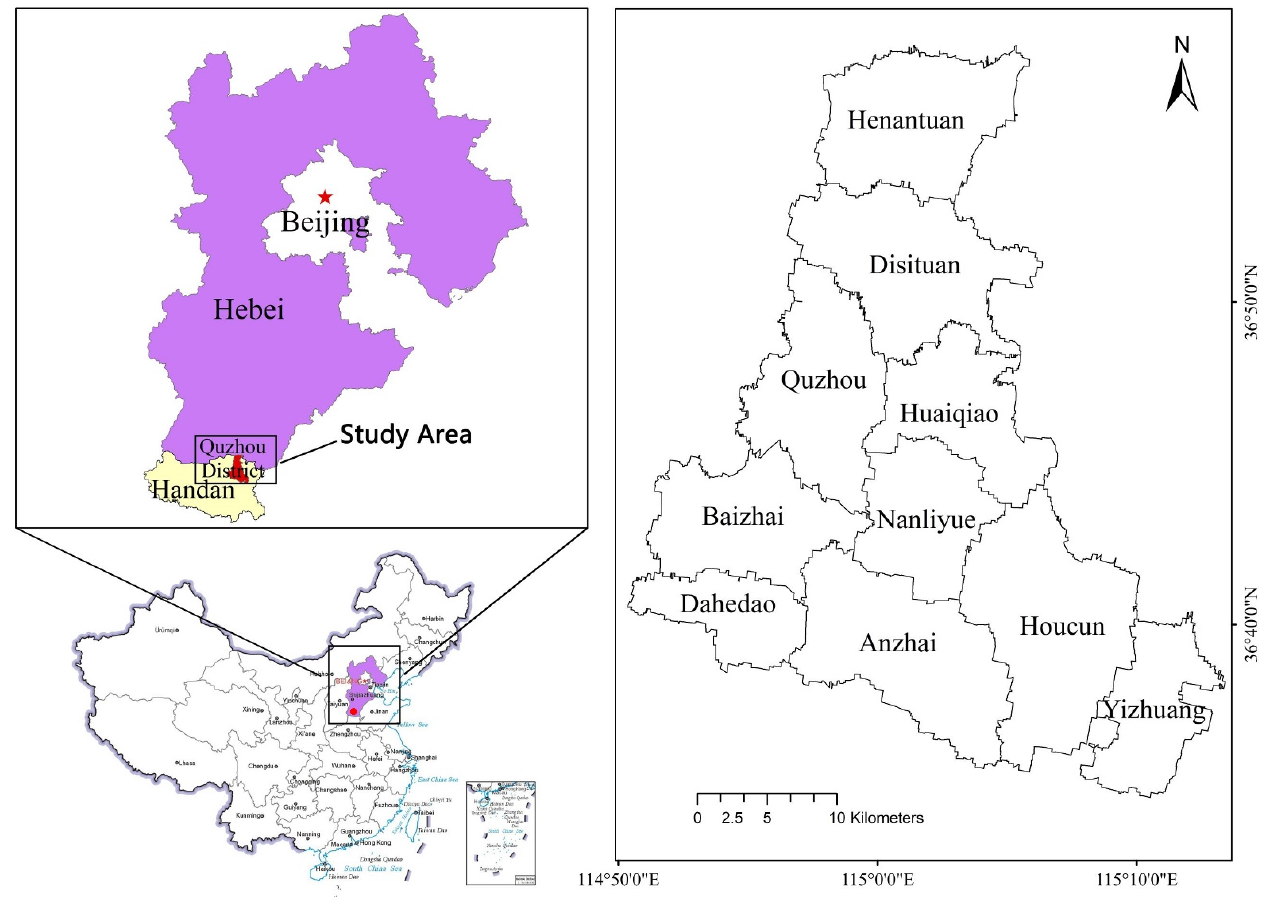
Figure 1. Location of Quzhou County in Hebei Province, China. Note: This map of China is from the standard map system of the Ministry of Natural Resources of China.